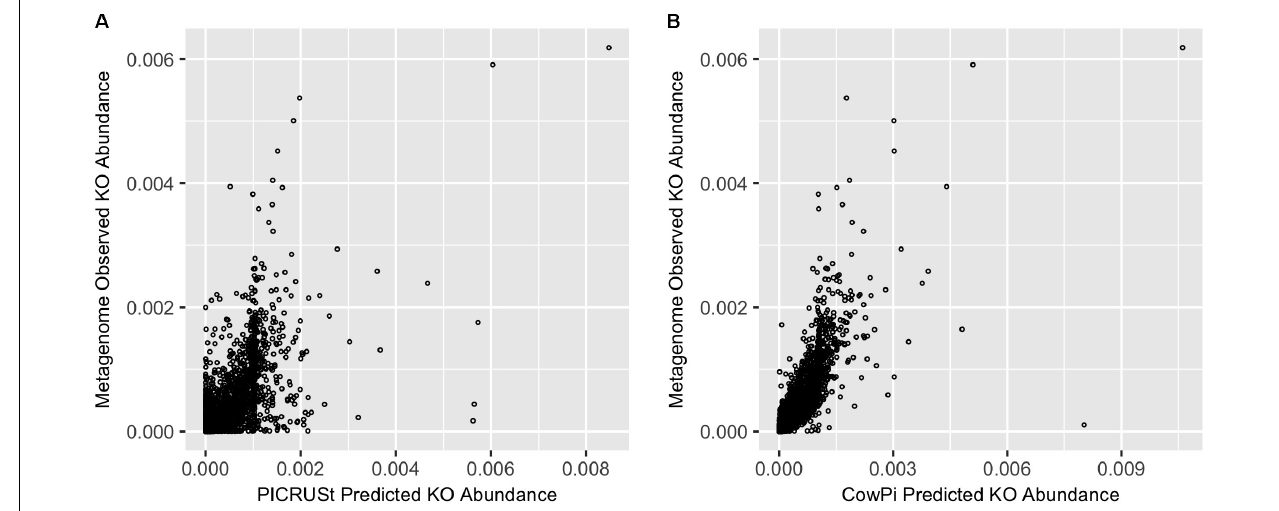
FIGURE 1 | Prediction accuracy on the Hess et al. (2011) dataset. (A) Metagenome compared with PICRUSt and (B) Metagenome compared with CowPI. Points represent the relative abundance of KOs in the observed ( y -axis) and predicted ( x -axis) dataset.